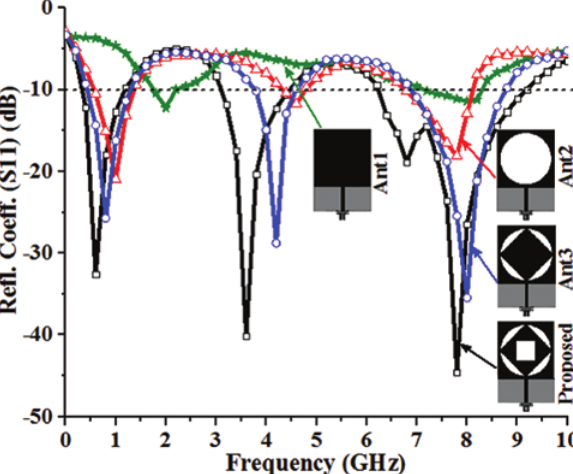
Figure 3: Variation of reflection coefficients vs. frequency for differ- ent antenna